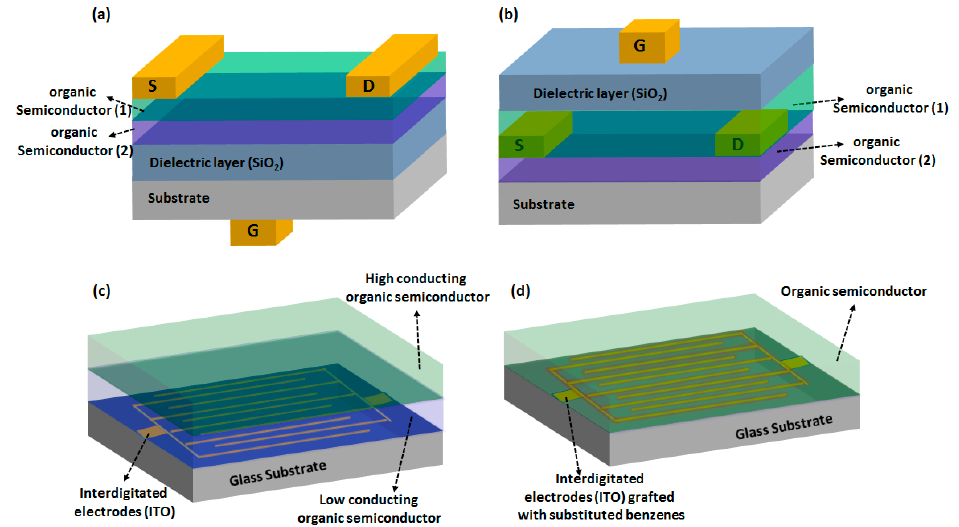
Figure 6. Scheme of OFET device designs in suspended gate ( a ) and top gate ( b ) configuration. of MSDI ( c ) and double lateral heterojunction ( d ) Scheme of MSDI ( c ) and double lateral heterojunction ( d ) device.